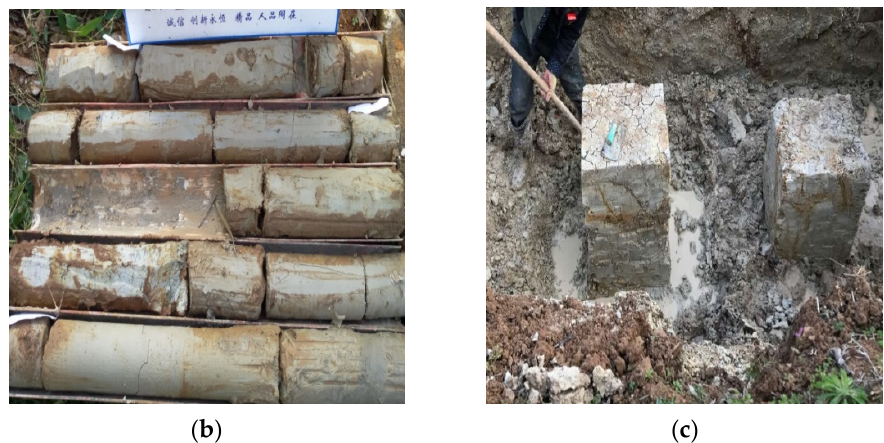
Figure 1. Test site and white diatomaceous earth: ( a ) Shengzhou diatomaceous earth slope test section; ( b ) white diatomaceous earth; ( c ) white diatomaceous earth drilling and construction.